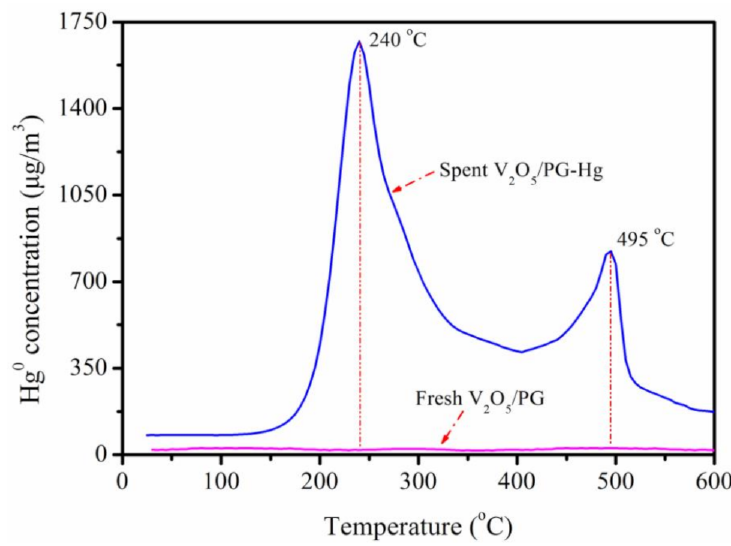
Figure 7. TPD profiles of fresh and spent 5V 2 O 5 /PG (reaction conditions: T = 30–600 ◦ C, N 2 = 200 mL/min, heating rate = 5 ◦ C/min).